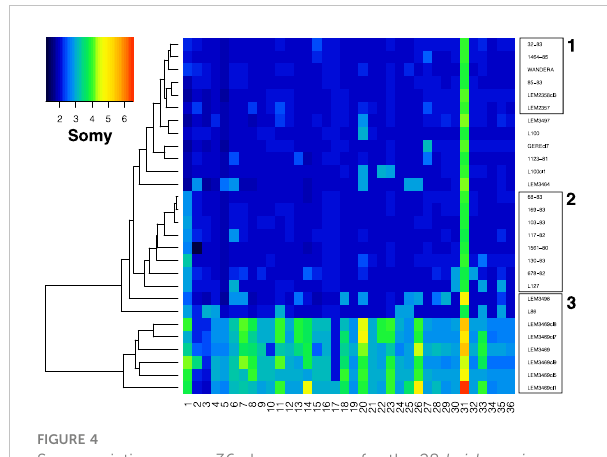
FIGURE 4 Somy variation across 36 chromosomes for the 28 Leishmania genomes sequenced in this study. Box 1 highlights genomes that are nearly diploid, box 2 highlights genomes with a trisomic chromosome 1 and box 3 highlights genomes showing high somy variability (see